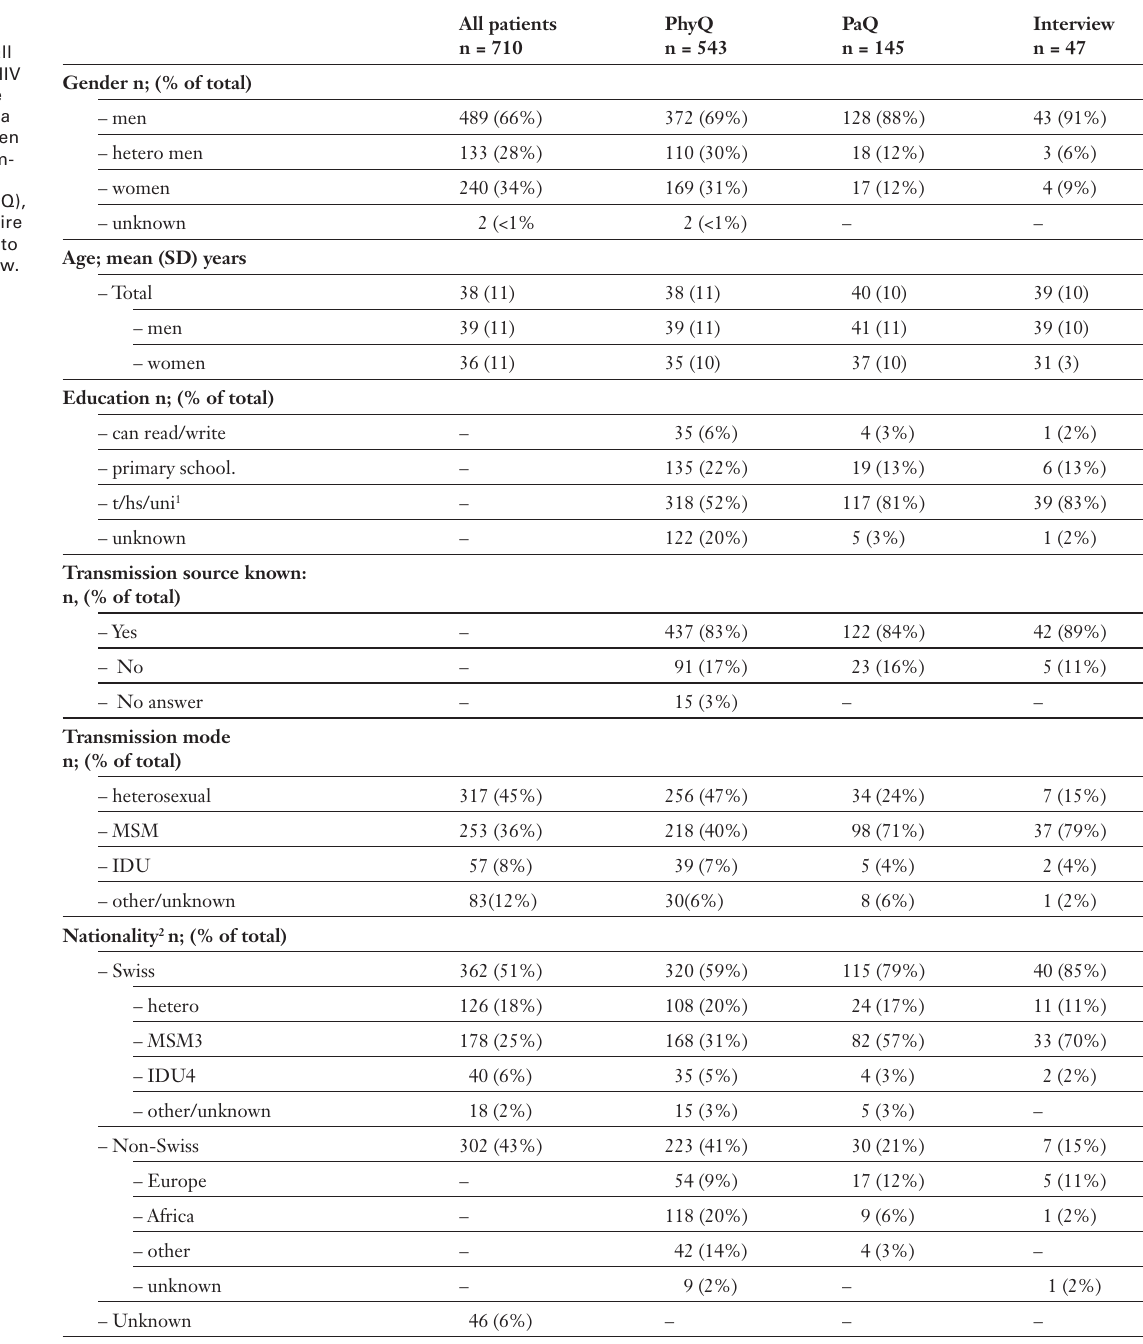
Table 1 Demographics of all newly diagnosed HIV patients during the study period, with a comparison between patients with a com- pleted physician questionnaire (PhyQ), patient questionnaire (PaQ), or agreeing to a personal